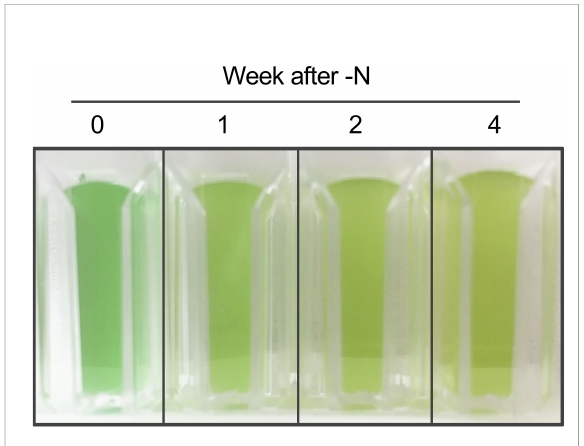
FIGURE 1 Photograph of Cyanidioschyzonmerolae cultureafter N-depletion.